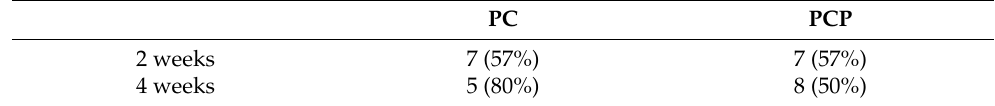
Table 1. number of operated animals (patency rate). Table 1. Number of operated animals (patency rate).